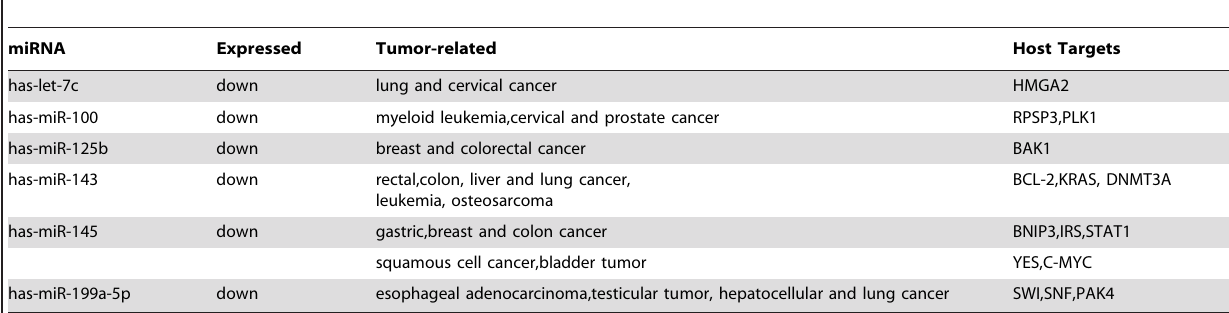
Table 1. Summary of the Associations of Six miRNAs with Advanced Tumor Stage, Lymph Node Metastasis, and Poor Survival in Small Cell Carcinoma of the